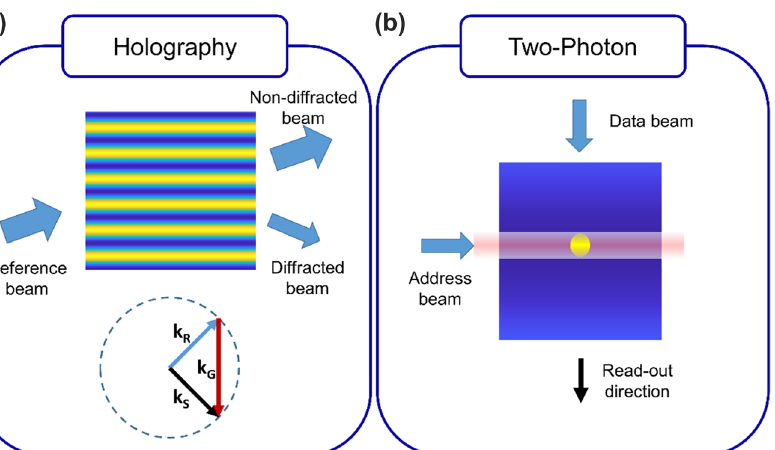
Figure 3: 3D optical memory implementations. (a) Diffraction from a sinusoidal grating according to Bragg matching condition. On Ewald’s sphere , k , and k refer to the wave vectors of the reference, signal, and recorded grating respectively. The reference beam simply representation, k R S G addresses and reads out the data stored in the grating. (b) Simple sketch of recording and read-out for a two-photon technique. Here, the address beam (analog of the reference beam in the case of holography) is depicted as a light sheet accessing a layer of the volume and the data beam encodes the information. During the read-out, the address beam selects the target layer to excite a fluorescence signal that would be modulated with respect to the recorded data (following the description in